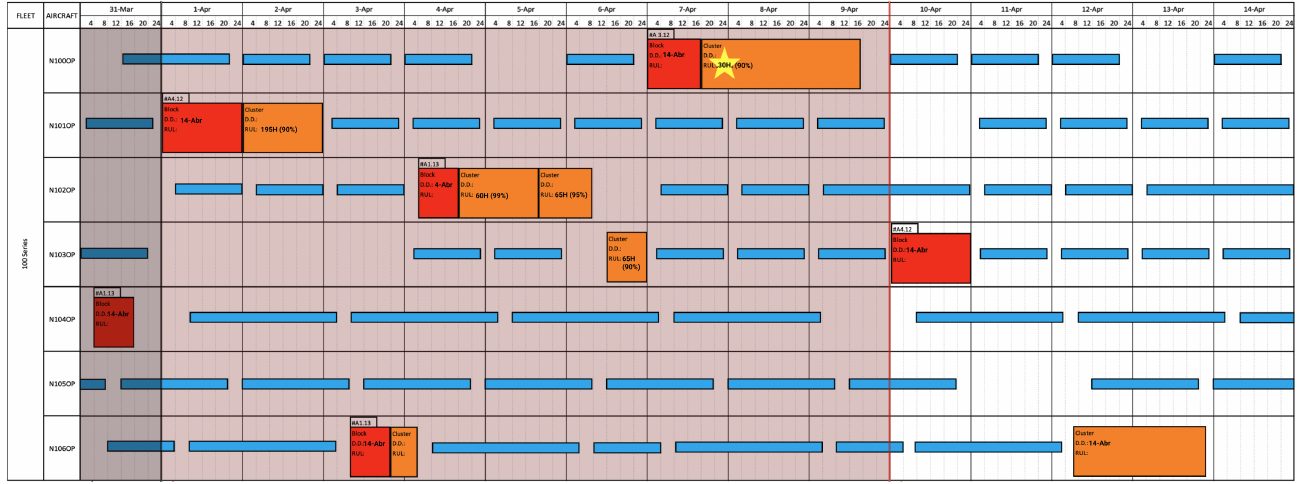
Figure 2. Maintenance scheduling problem presented to the participants in the experimental session.